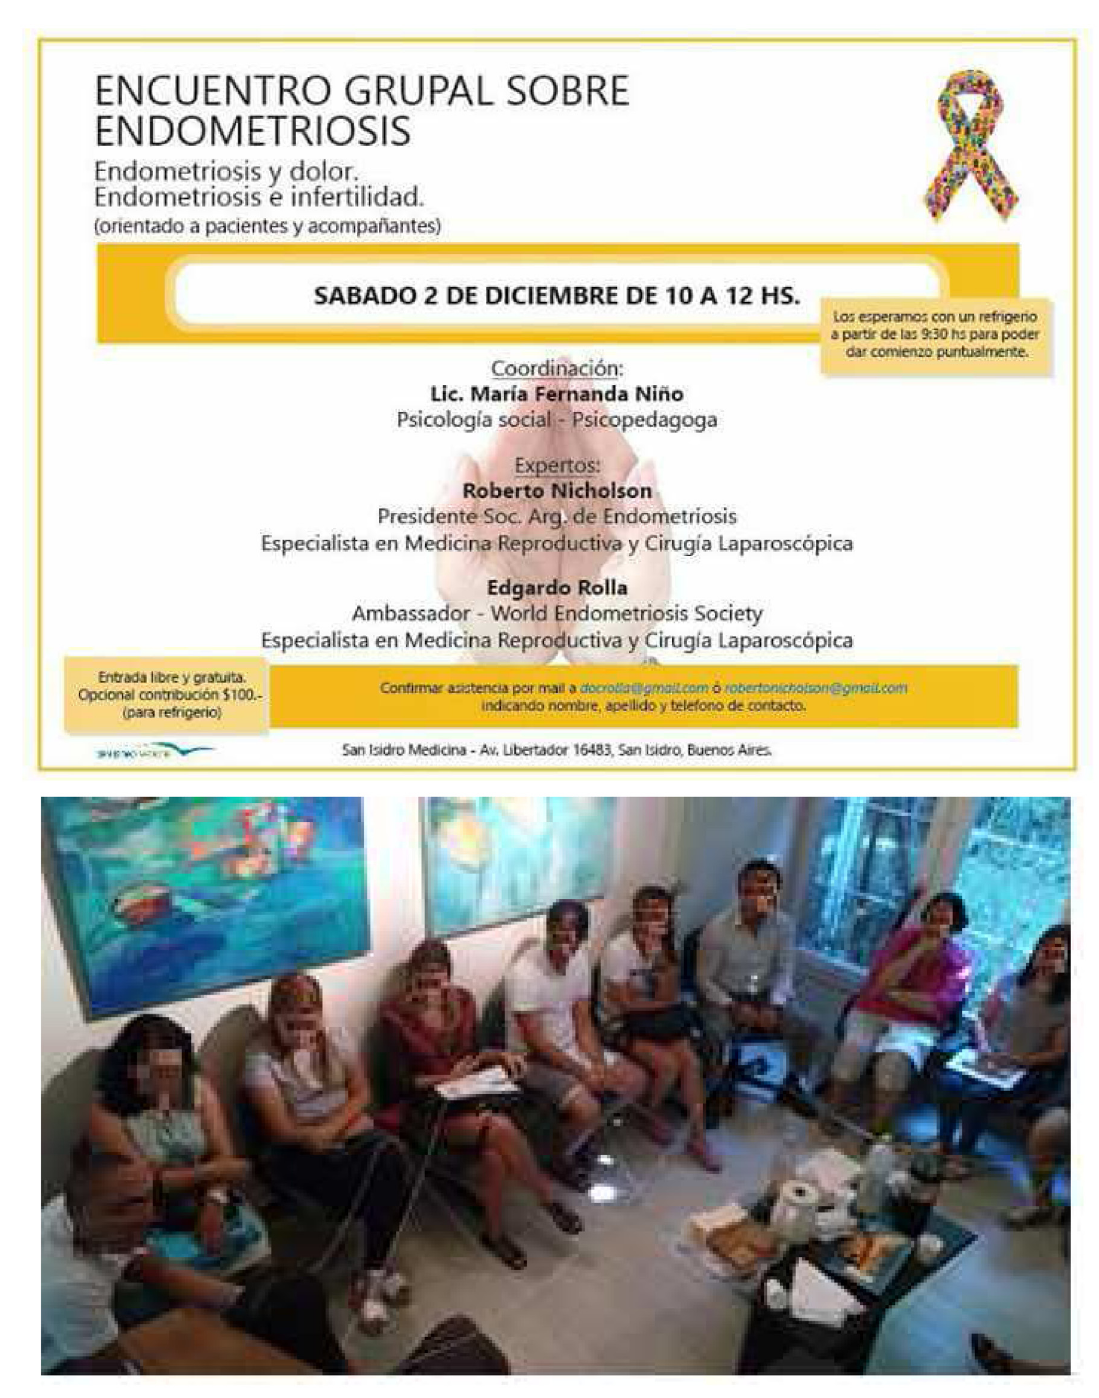
Figure 10. Poster inviting the public to attend a patients’ workshop with doctors and social psychologists and a photo from the workshop. Photo by the author.